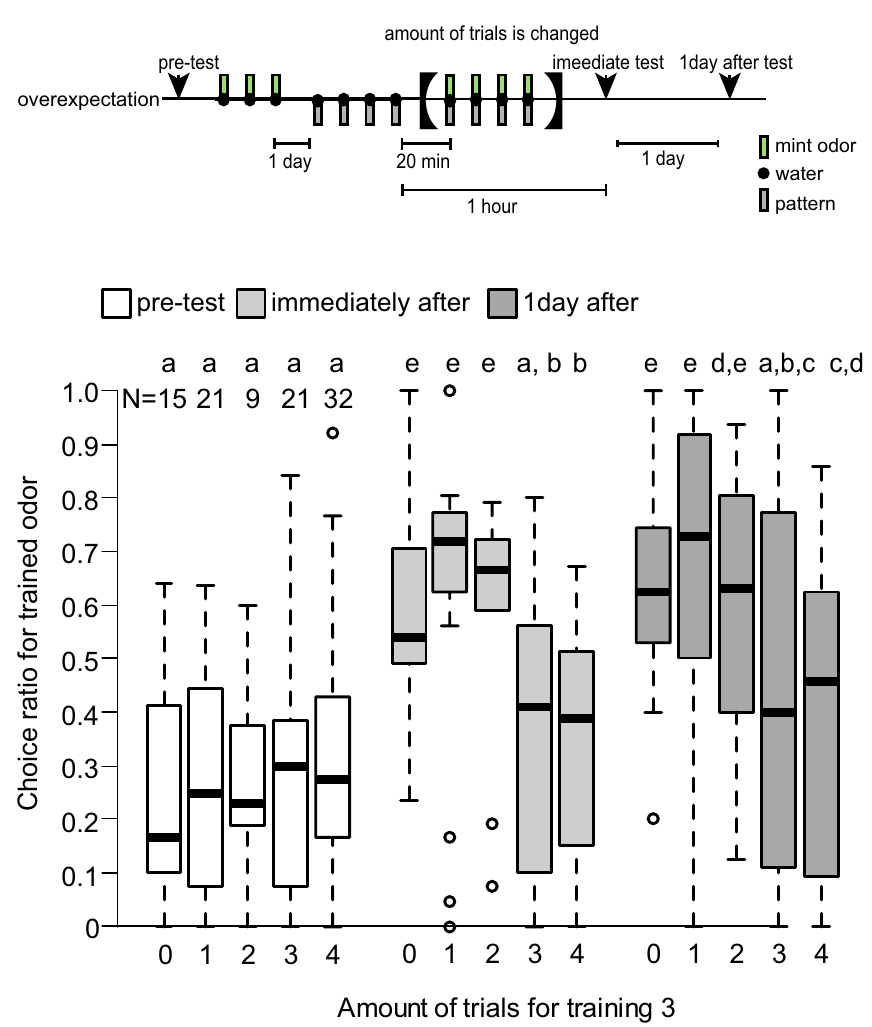
Figure 4. Results of Experiment 3: Effect of overexpectation depends on the number of compound conditioning trials. Crickets were subjected to 3 conditioning trials in which mint odour was paired with water (O+ training). One day later, they were subjected to 4-trial pairing of a white-centre and black-surrounding pattern with water (P+ training). Twenty min later, they were subjected to 0 to 4 pairings of an odour-pattern compound with water (OP+ training). The relative odour preference was tested before training, 1 h after completion of P+ training, and 1 day after conditioning. The results in pre-test (white), immediate test (light grey) and 1 day after test (dark grey) are shown as box and whisker diagrams. A GLMM was used to examine relative preferences for the conditioned odour (Supplemental Tables 4 and 5). Different letters indicate significant difference in pairwise comparisons from post-hoc tests ( p <